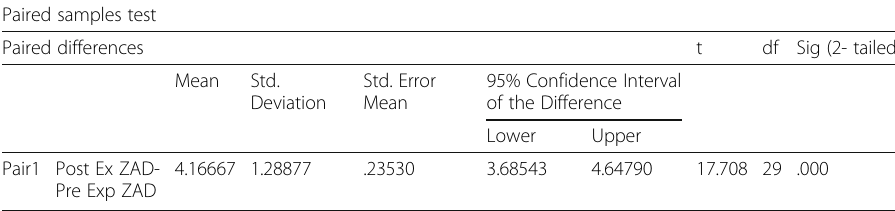
Table 6 Paired samples T-test of the experimental group ’ s ZAD performance Paired samples test Paired